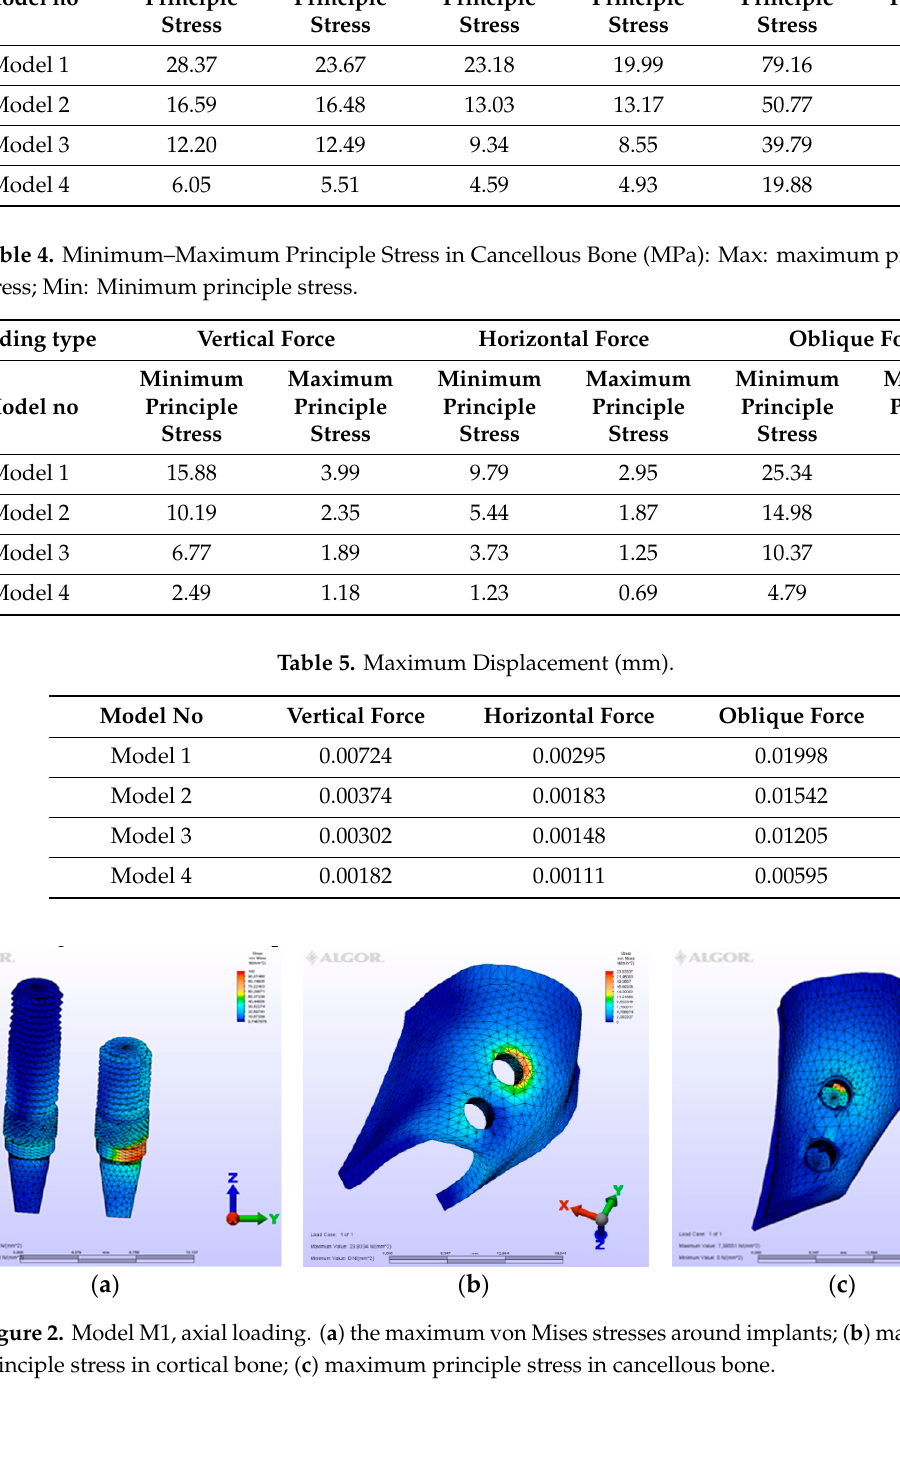
( c ) Figure 3. Model M1, oblique loading. ( a ) the maximum von Mises stresses around implants; ( b ) maximum principle stress in cortical bone; ( c ) maximum principle stress in cancellous bone. ( a ) ( c ) Figure 4. Model M1, horizontal loading. ( a ) the maximum von Mises stresses around implants; ( b ) maximum principle stress in cortical bone; ( c ) maximum principle stress in cancellous bone. 3.1.2. M2 Model In the second model, a conventional three-unit partial prosthesis is supported by two implants. The distal implant was placed bicortically between the crestal cortical and sinus cortical plates. Because of this bicortical support, the stress values at the mesial and distal implants were measured to be similar. Importantly, however, greater von Mises stress values at the distal neck region of the distal implant, at the implant-abutment junction specifically, were detected. Maximum principle stresses were calculated at the mesial cortical region of the mesial implant neck and at the mesial cancellous region of the same implant. Minimum principle stresses were valued at the vestibular